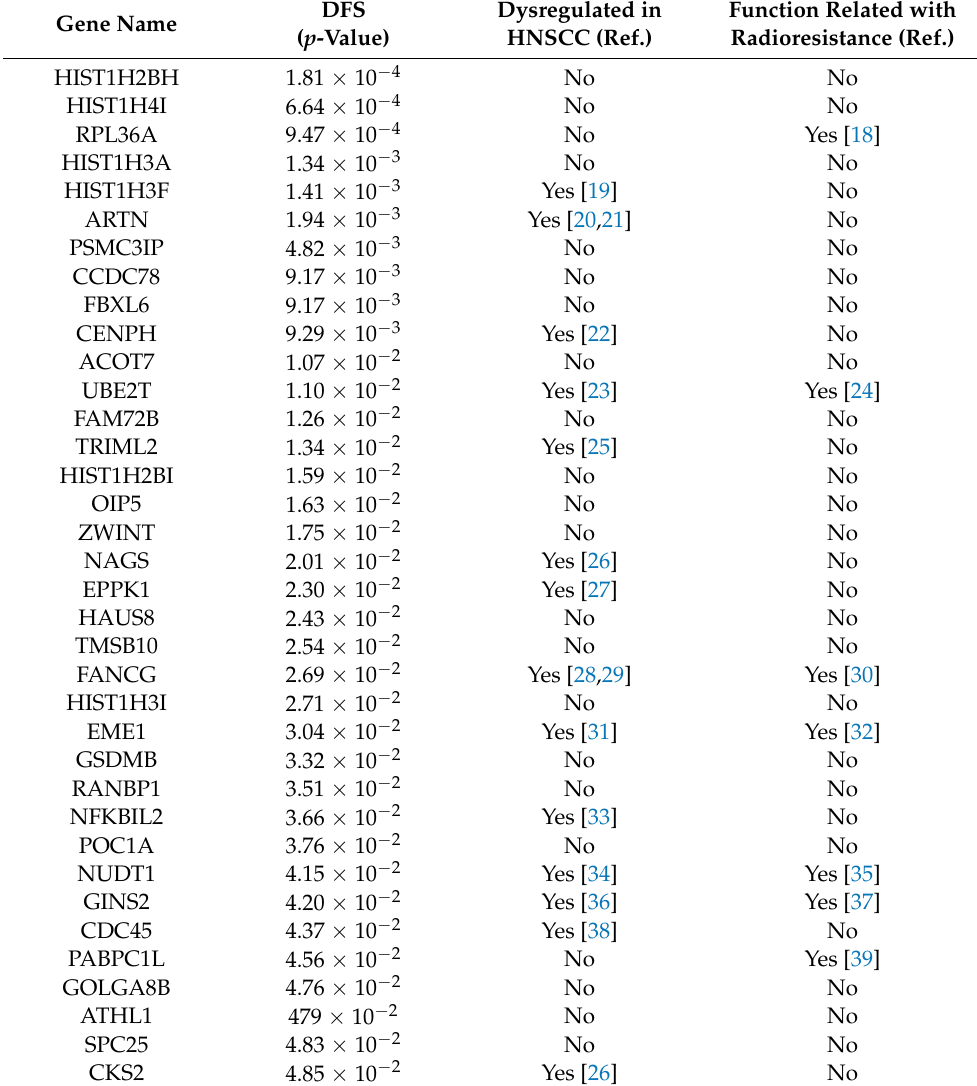
Table 1. List of 36 specific radioresistance-associated gene candidates in